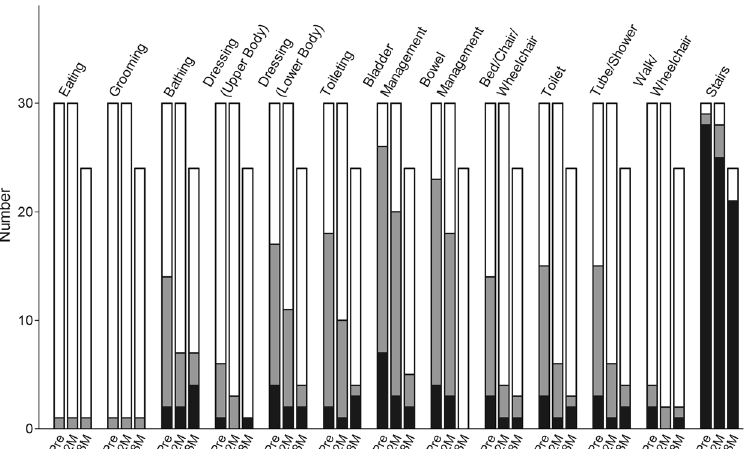
Figure 10. Numbers of different levels of dependence at each time point in the thoracolumbar group, translated from the Functional Independence Measure. Black bar = complete dependence on the helper, grey bar = modified dependence on the helper, white bar = no dependence on the